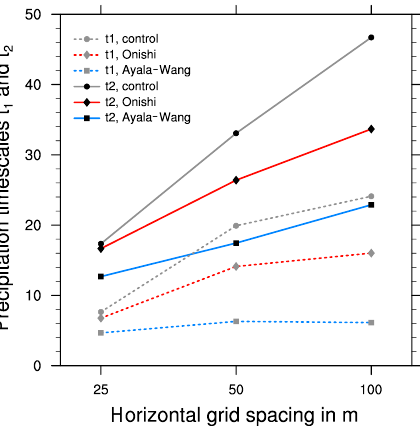
Figure 9. As Fig. 7 but showing the dependency of the rain for- mation timescales t 1 and t 2 on horizontal grid spacing for a cloud droplet number density of 50cm − 3